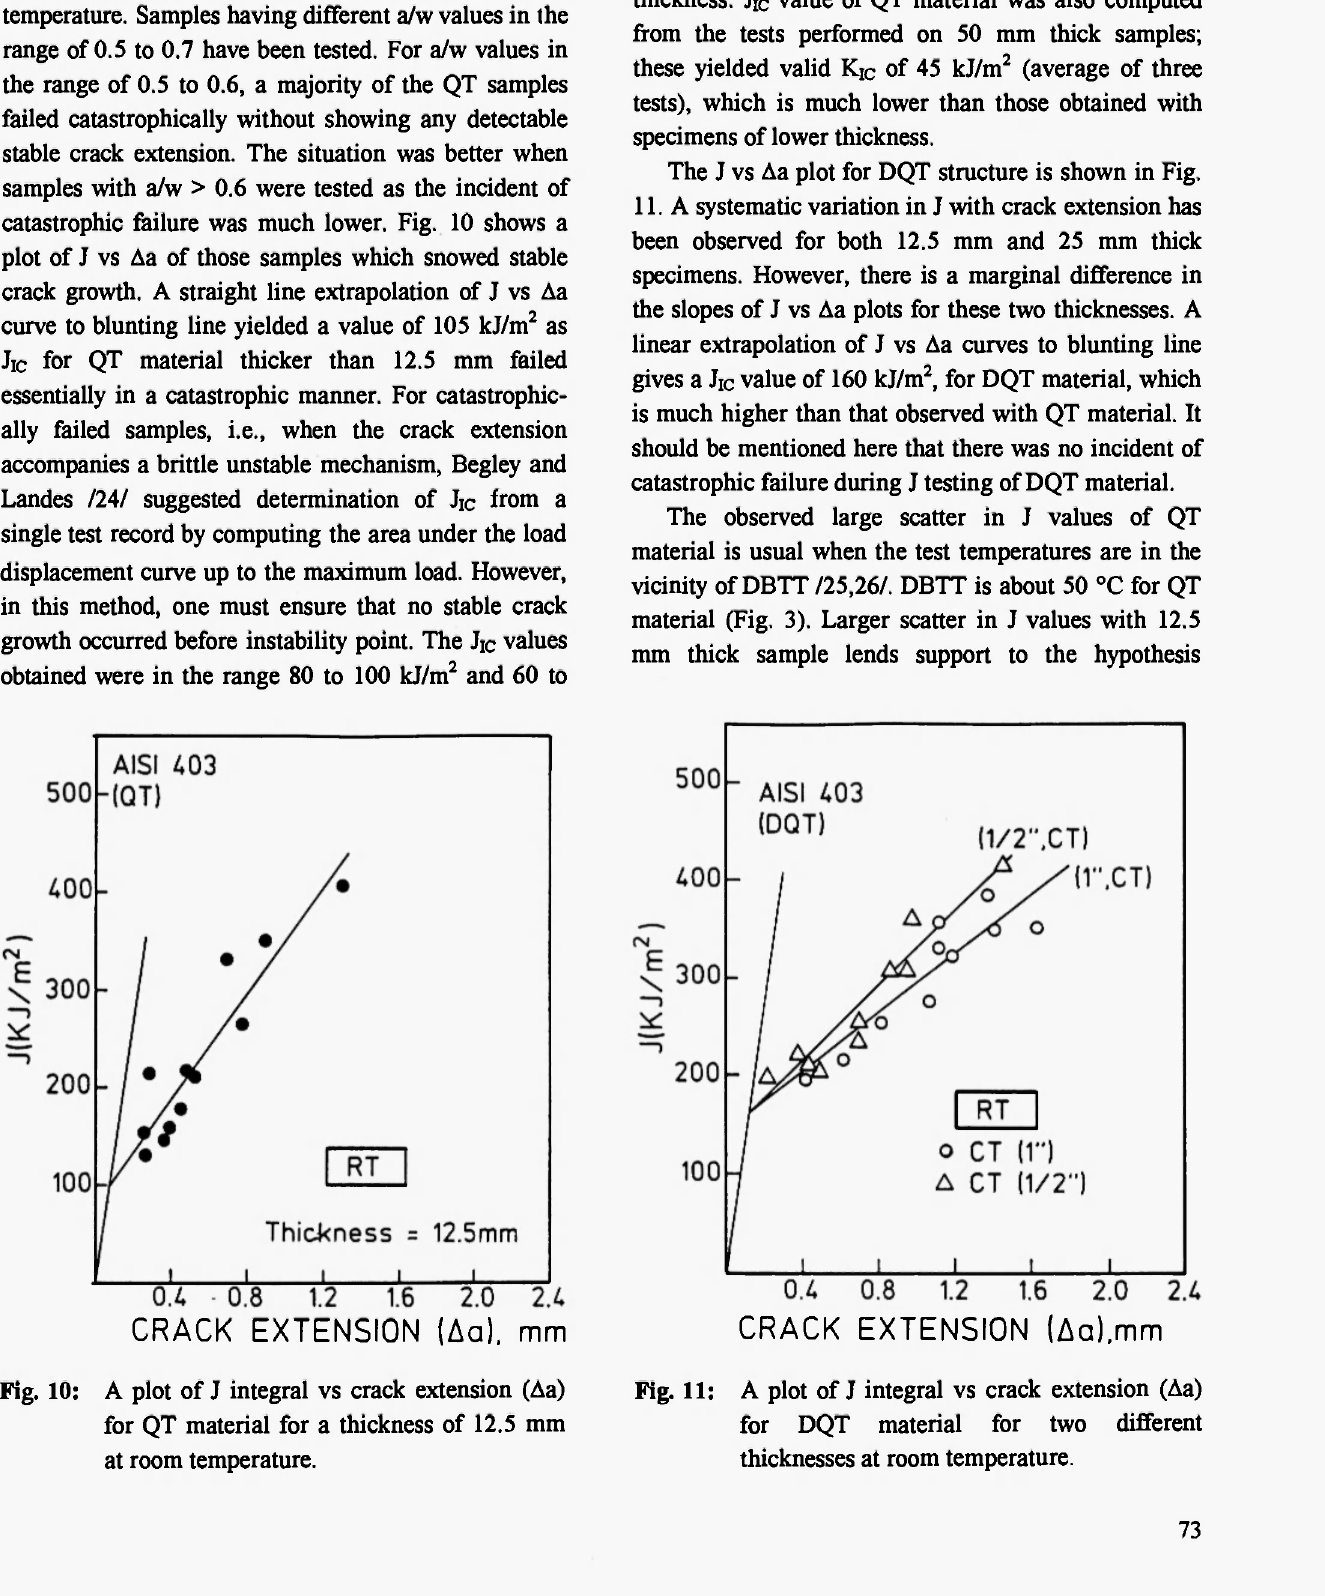
A plot of J integral vs crack extension